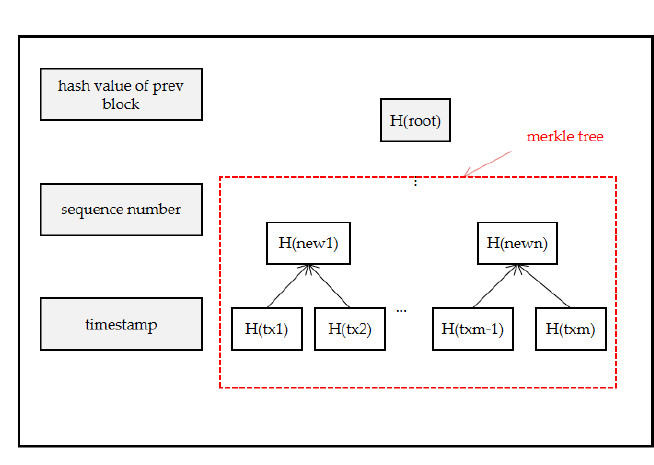
Figure 10. Block structure.